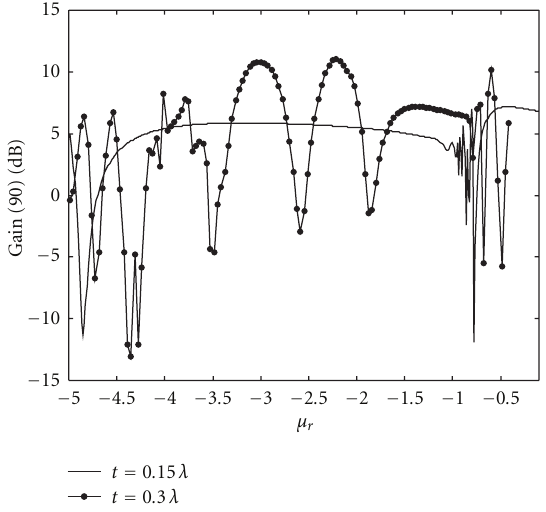
Figure 5: Gain versus μ r for an axially slotted elliptic cylinder coated with magnetic metamaterials. a c = λ , b c = λ /2, b = b c + t , ν = 90 ◦ , α = 2 . 8657 ◦ , and ε r = − 4 . 0